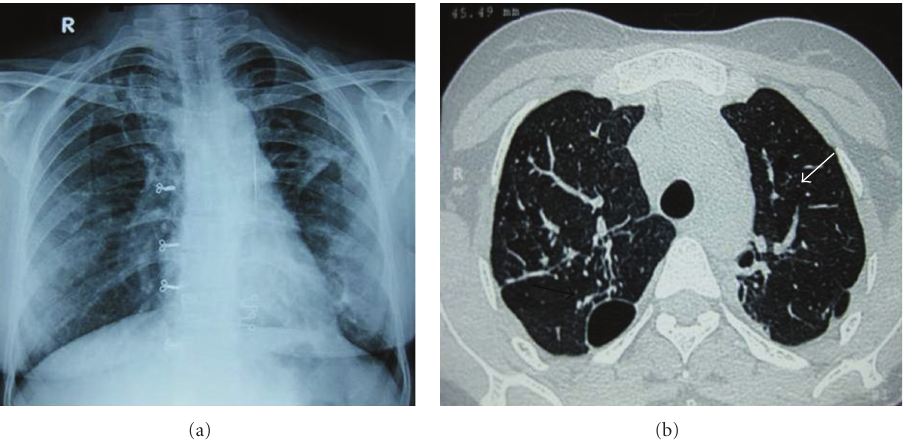
Figure 3: Follow-up (at end of chemotherapy) chest X-ray (a) showing complete resolution of pneumothorax on left side and computed tomography (b) revealing persistence of cystic space in right upper lobe (black arrow) and resolution of left pneumothorax (white